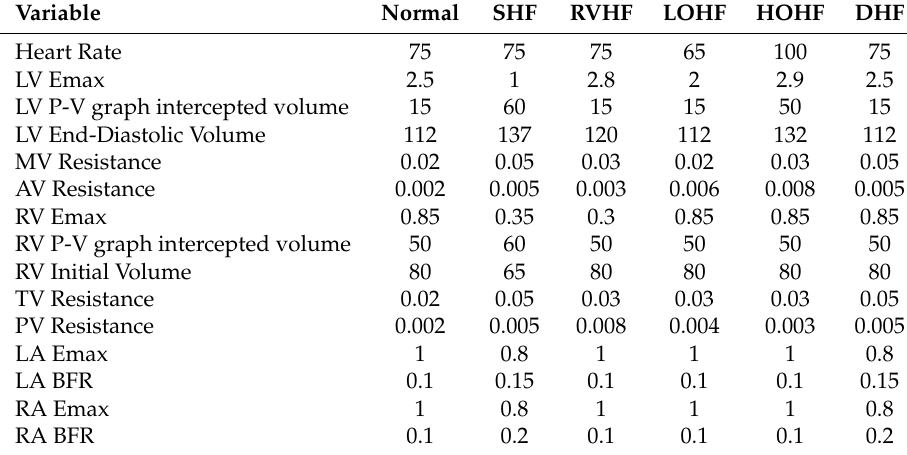
Table 2. Values of the input variables for the simulation of different